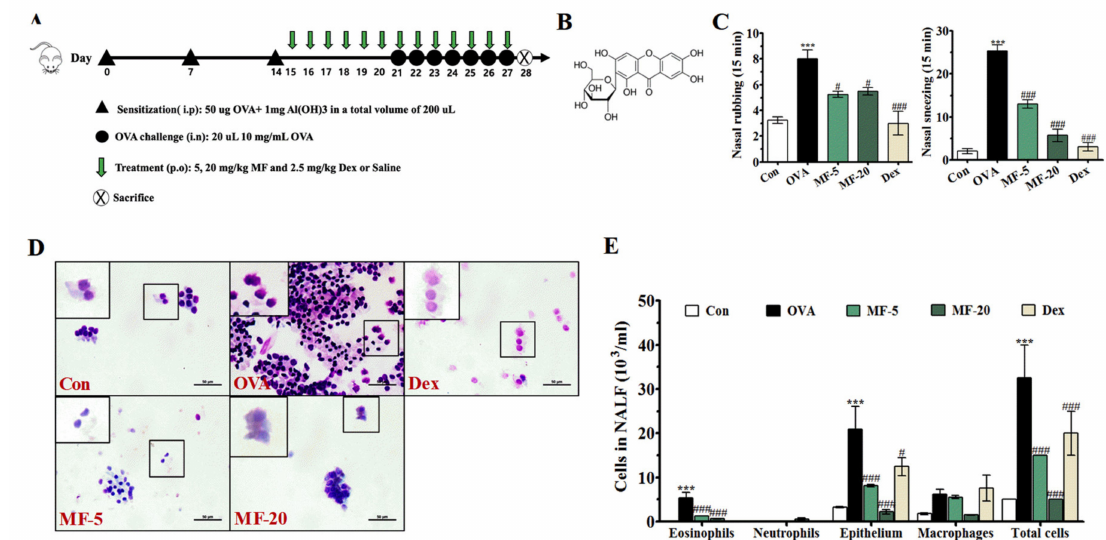
Figure 1. E ff ect of Mangiferin (MF) on nasal symptoms and allergic inflammation of OVA-induced allergic rhinitis (AR) mice. ( A ) Experimental protocol ( B ) Chemical structure of MF. ( C ) The frequency of nasal rubbing and sneezing numbers after the final OVA challenge was assessed by counting for 15 min without anesthesia. ( D ) Cytospin cell preparations were made by NALF and stained with Di ff -Quik; Scale bar = 50 µ m. ( E ) Total and di ff erential cell numbers were counted using a hemocytometer. *** p < 0.001 , significantly di ff erent from the value of the Control group. # p < 0.05, ### p < 0.001 , significantly di ff erent from the value of OVA